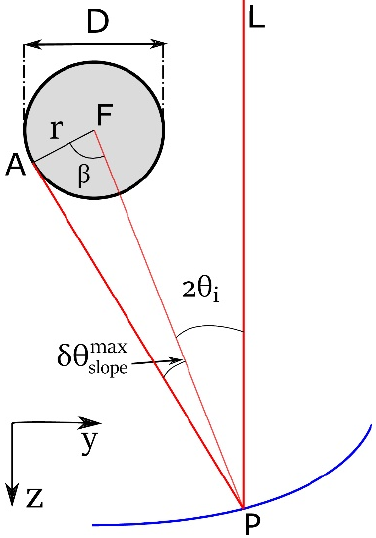
Figure 15. Scheme for the calculation of the local intercept factor .